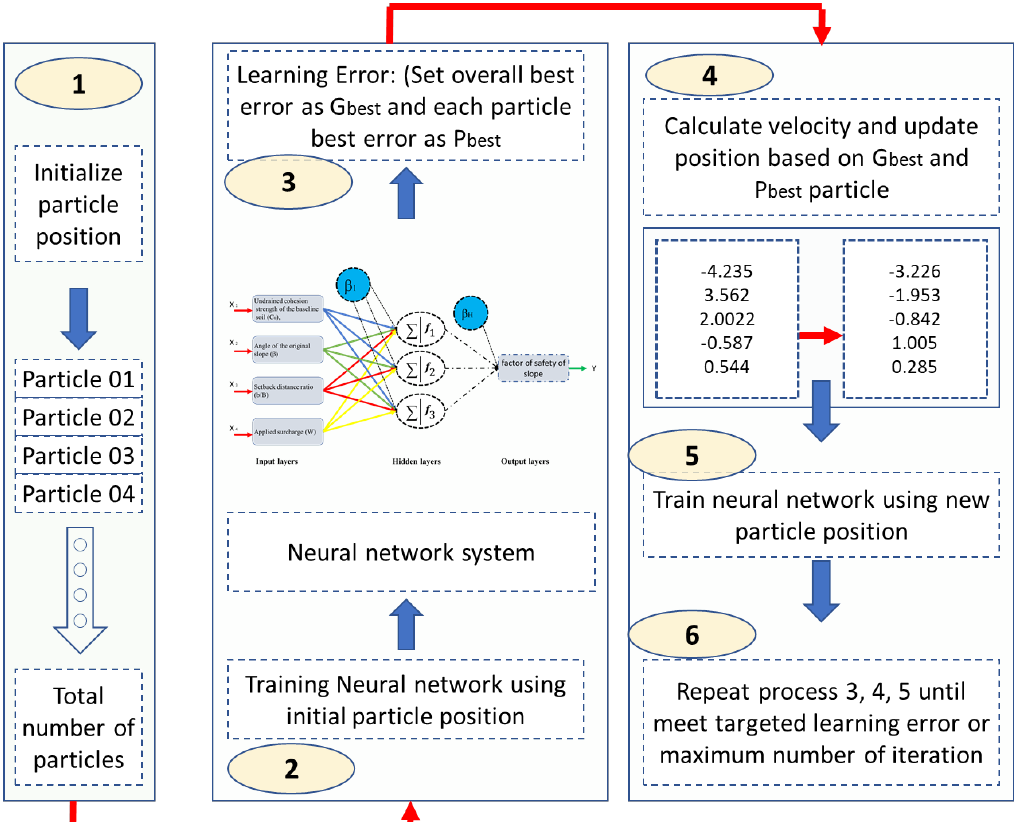
Figure 3. The learning approach of PSO – ANN.